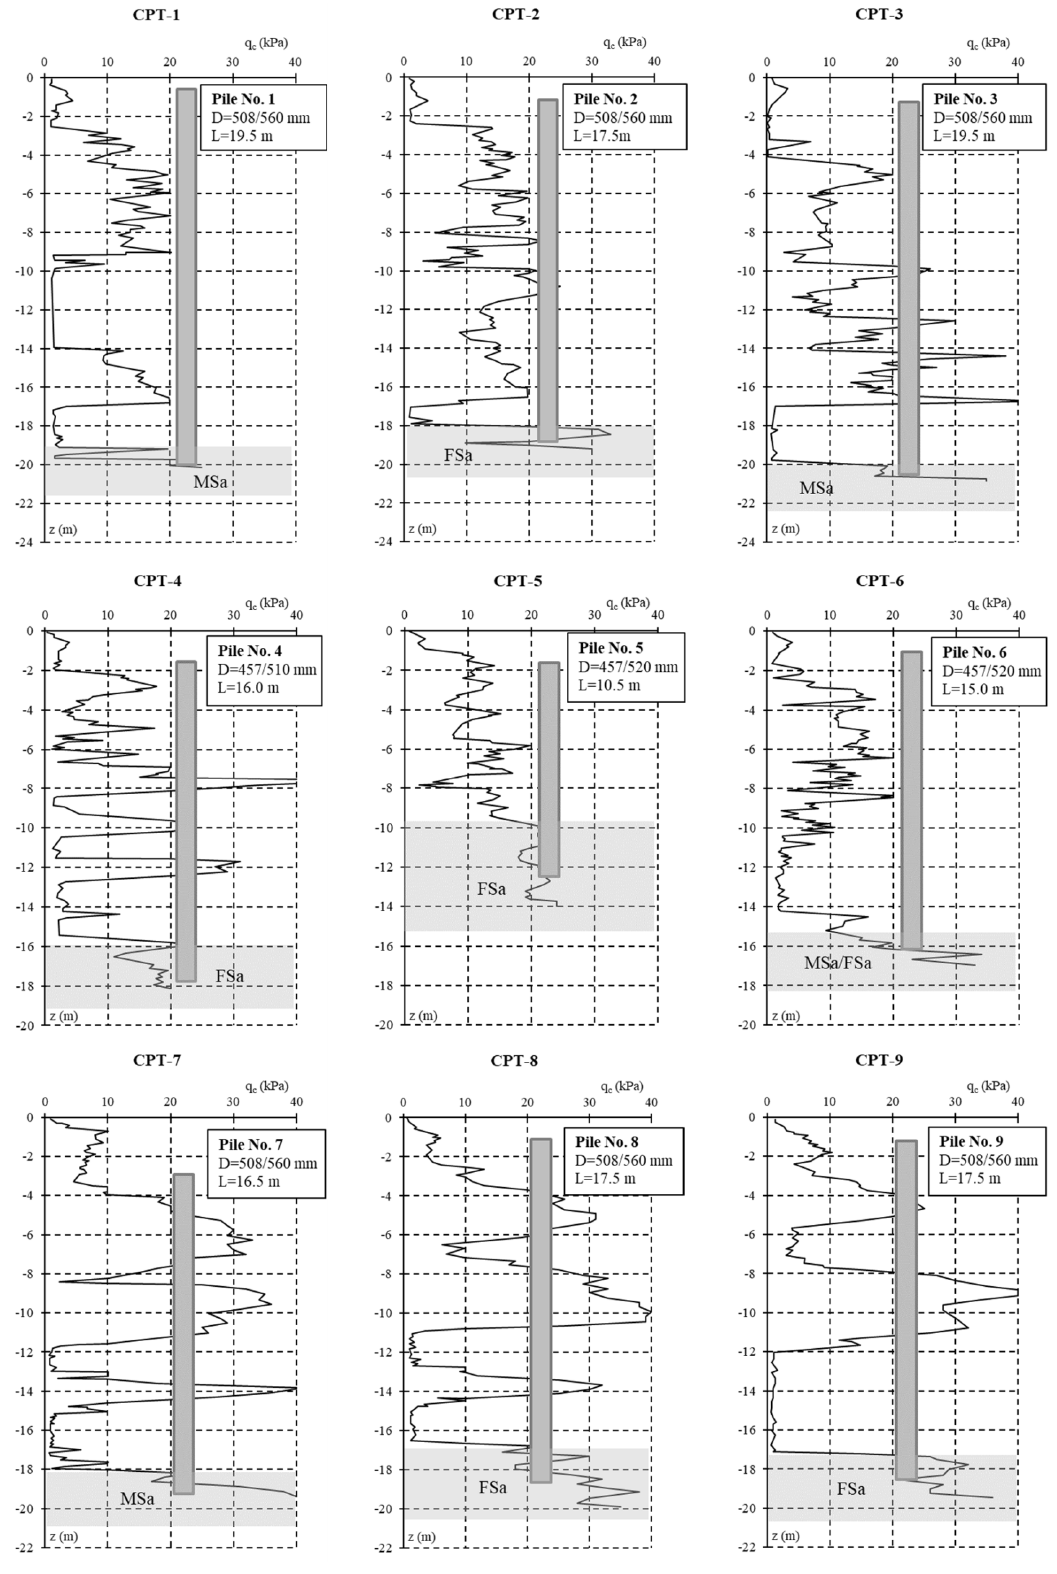
for example piles (Gdańsk: CPT-1 to CPT-3, Szczecin: CPT-4 to CPT-6, Grudziądz: CPT-7 to Figure 9: Diagrams of resistance q c